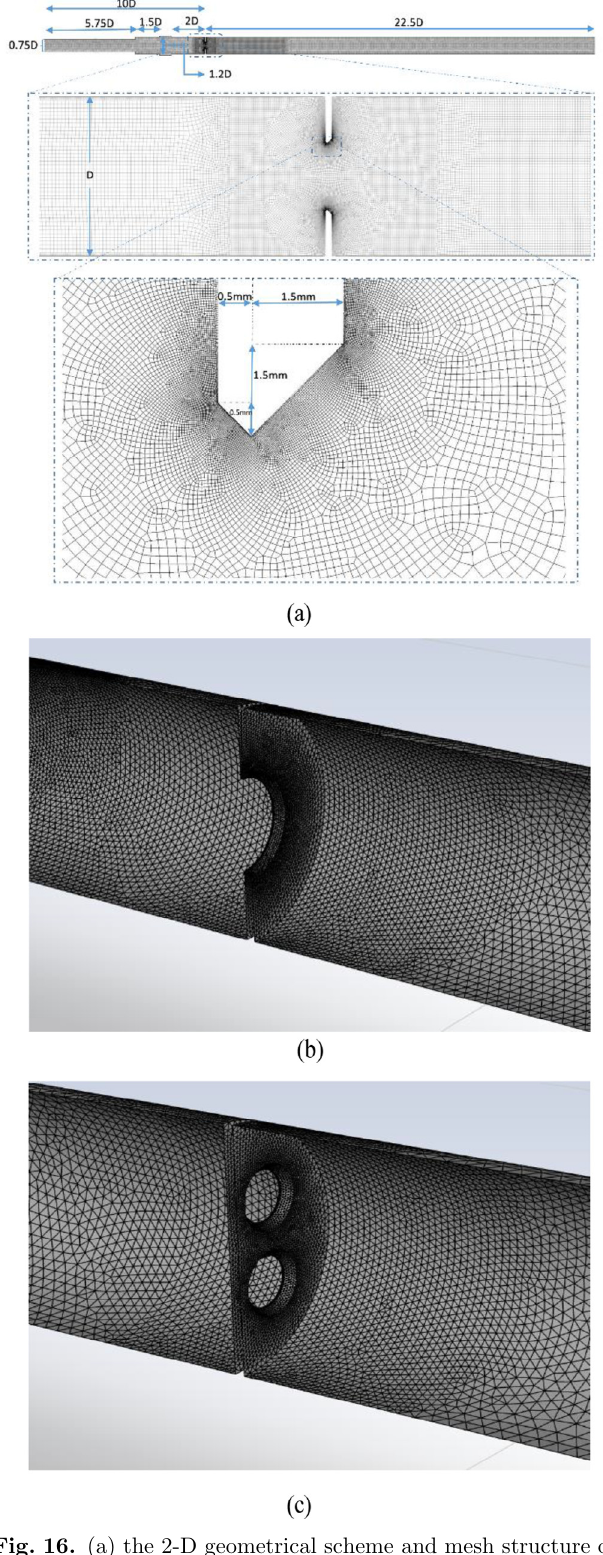
Fig. 16. (a) the 2-D geometrical scheme and mesh structure of the single-hole ori fi ce with a two-sided sloped edge at b = 0.4. (b) the 3-D mesh structure of the single-hole ori fi ce with a one- sided sloped edge at b =0.4. (c) the 3-D mesh structure of the multi-hole ori fi ce with two-sided sloped edge at